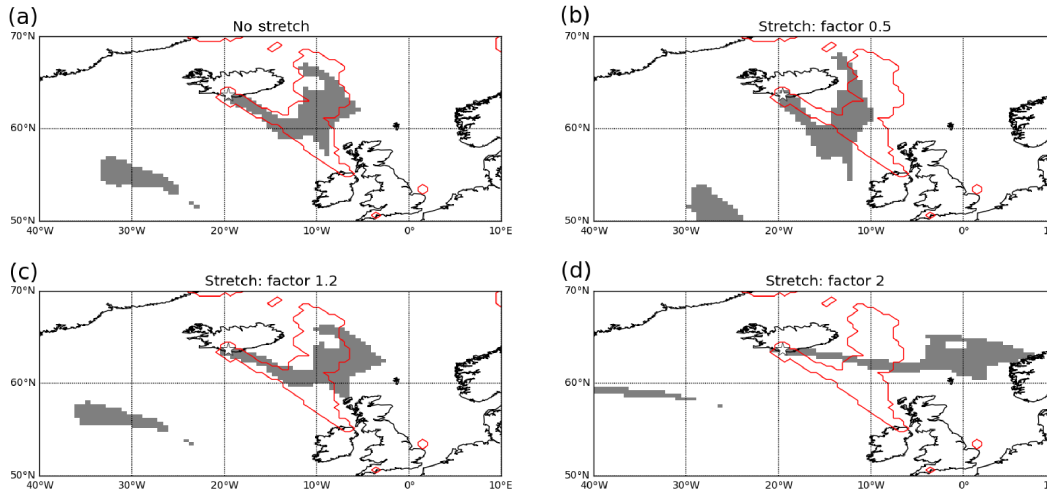
Figure 4. The pixel matched NAME ash cloud (grey shading) compared to the satellite-retrieved ash cloud (red outline) with (a) no stretch,